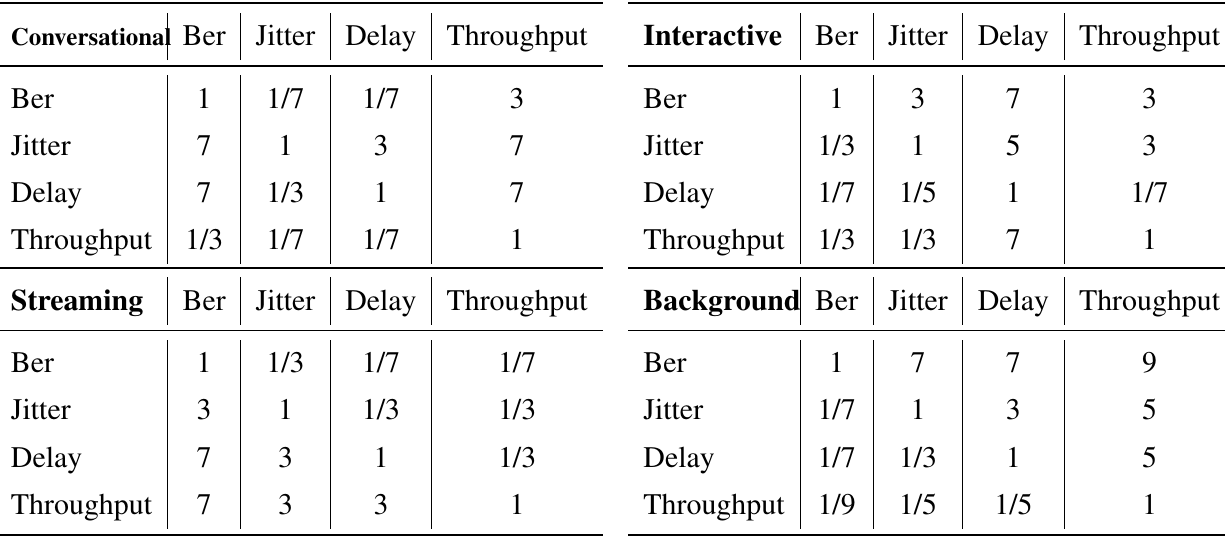
Table 2. Analytic Hierarchy Process (AHP) Matrices for Each Traffic